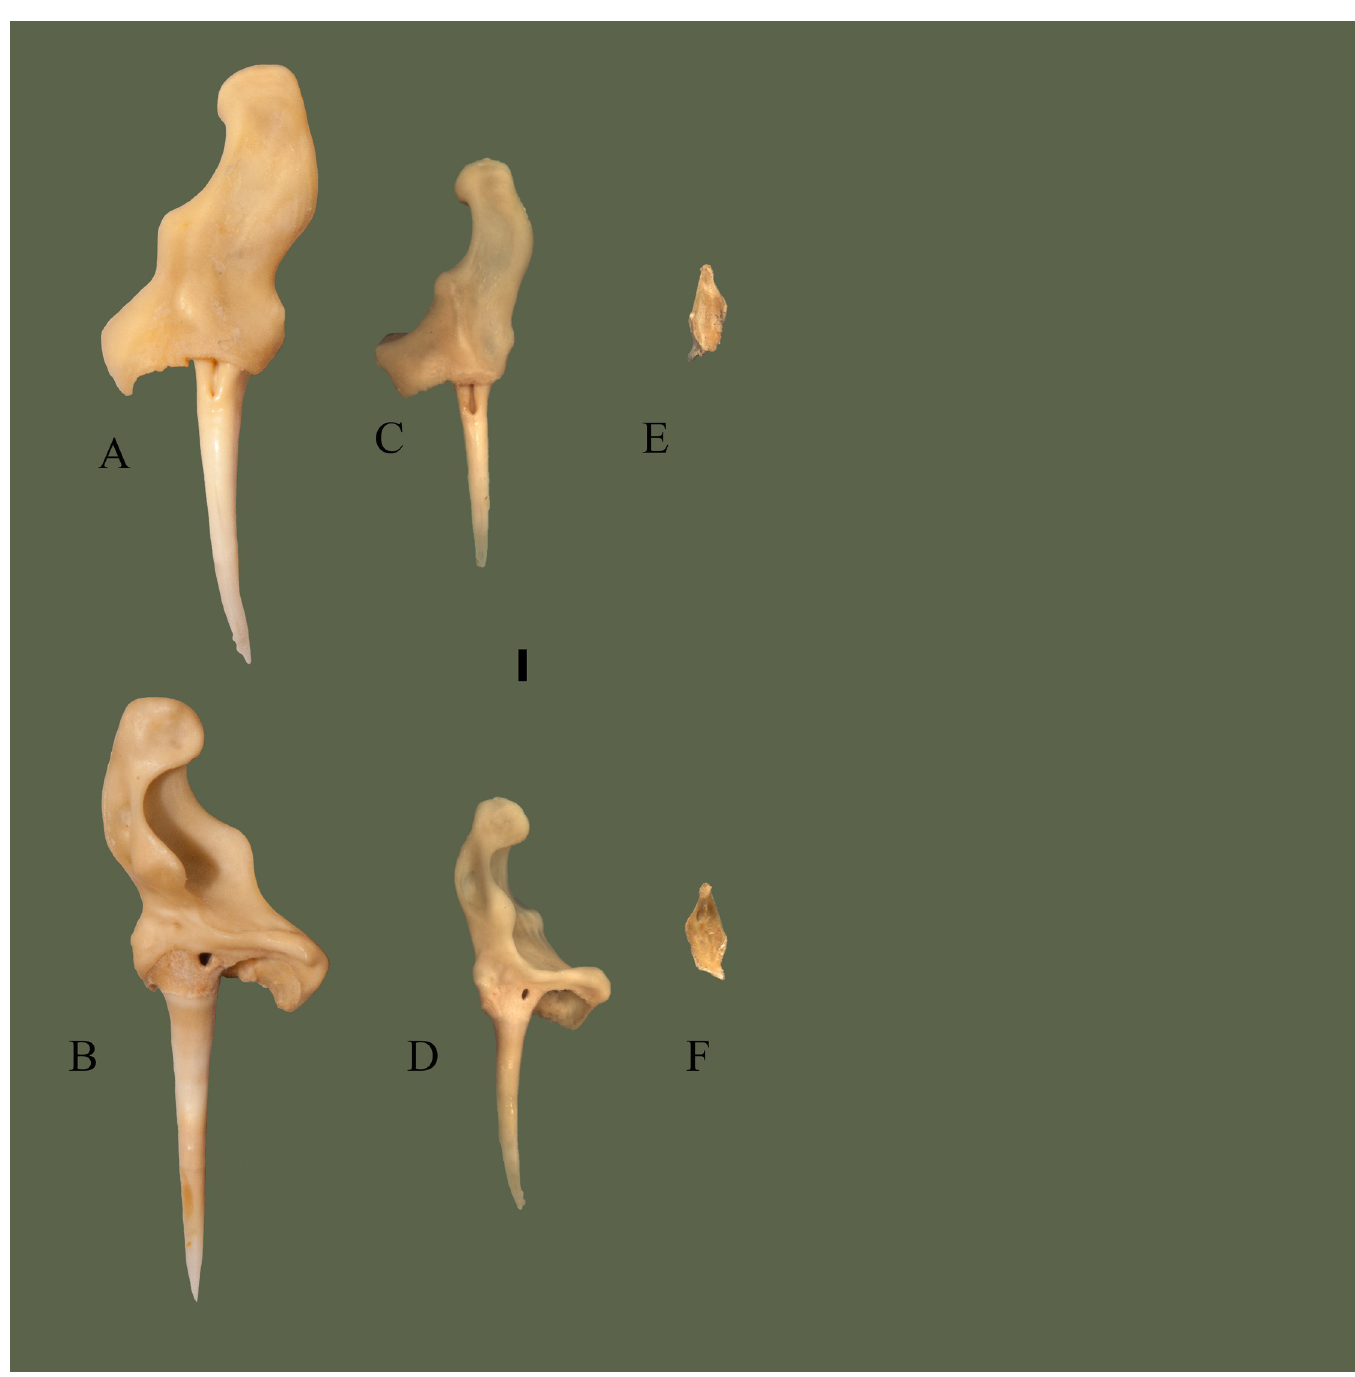
Fig 23. Maxilla ontogeny. ETVP 3295 in dorsal (A) and ventral (B); ETVP 3293 in dorsal (C) and ventral (D); ETVP 3306 in dorsal (E) and ventral (F). Dorsal is to the top of the page. Scale bar = 1